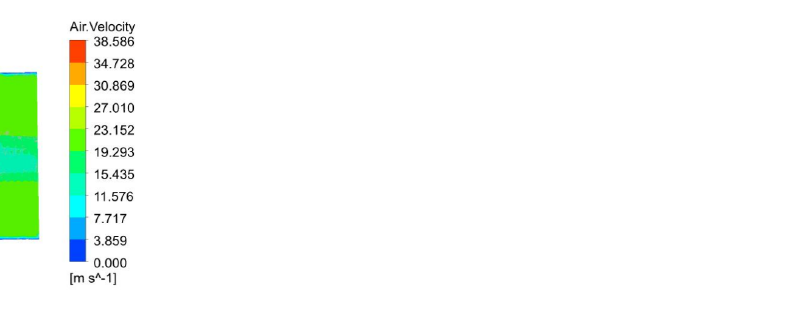
Figure 33. Distribution map of contamination on various sides of the insulator. ( a ) the contamination distributions on the windward side of 1# insulator; ( b ) the contamination distributions on the leeward side of 1# insulator; ( c ) the contamination distributions on the windward side of 2# insulator; ( d ) the contamination distributions on the leeward side of 2# insulator.